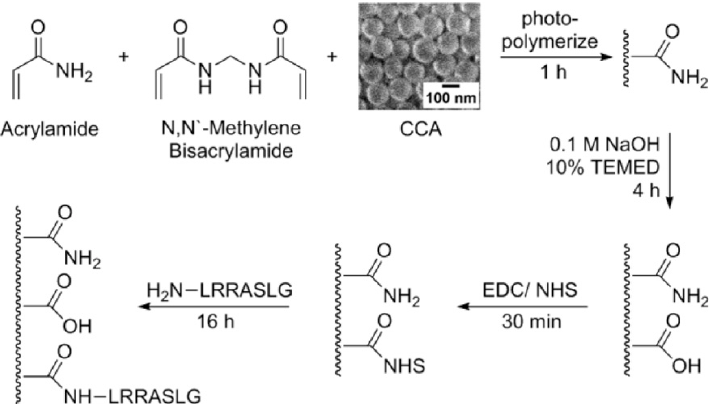
Figure 13. Fabrication of a Kinase Responsive CCA (crystalline colloidal array) Biosensor. Reproduced with permission from [40]. Polymers 2016 , 9 , 436